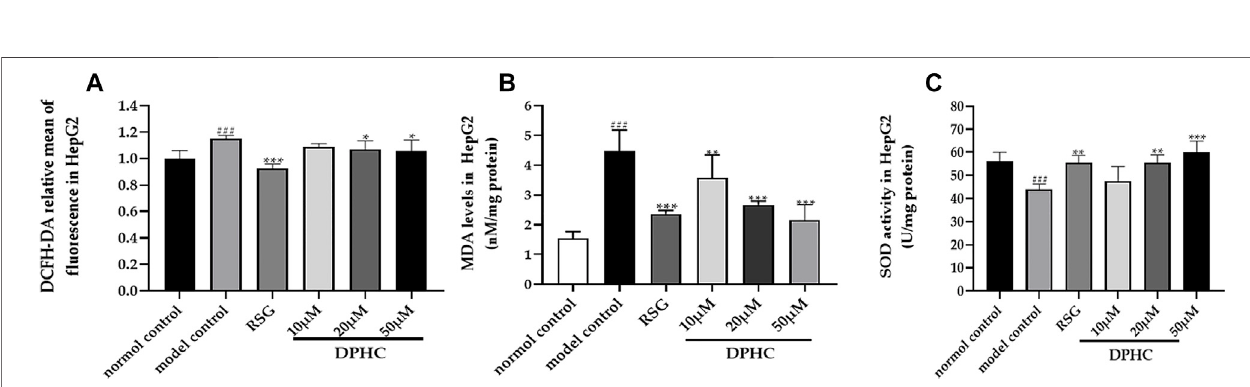
FIGURE9| EffectsofDPHConintracellularROS,MDA,andSODlevelsinIR-HepG2cells. (A) ROS. (B) MDA. (C) SOD.Allvaluesareexpressed asmeans ± SD,n (cid:1) 4. * p < 0.05, ** p < 0.01, *** p < 0.001 compared with the model control group, and ### p < 0.001 compared with the normal control group.